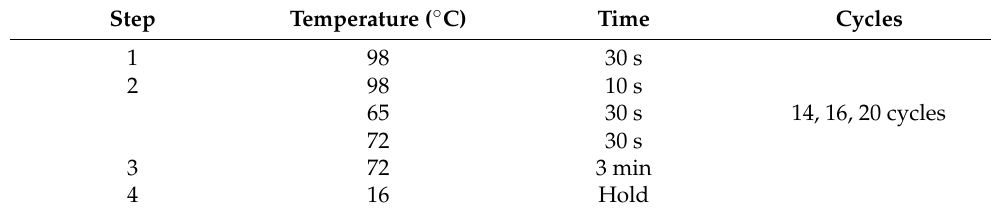
Table 13. PCR Scheme for Second